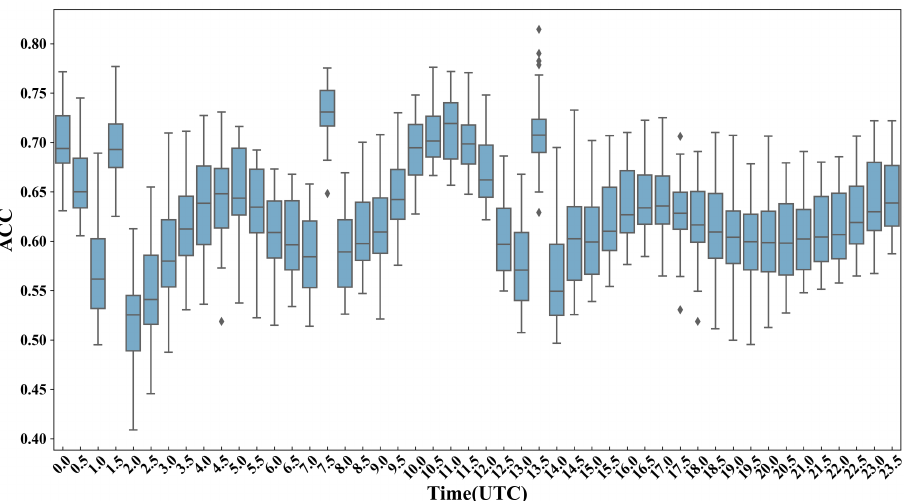
Figure 11. The diurnal variation of ACC for the precipitation grades’ estimation in testing dataset during August 2018; the distributions of the statistical values by half-an-hour are interpreted in box plots. Box diagrams indicate the 25th, 50th, and 75th percentiles, whereas the periphery of the box extends to 1.5-times the quartile deviation (25th–75th percentile). Outliers are indicated by black